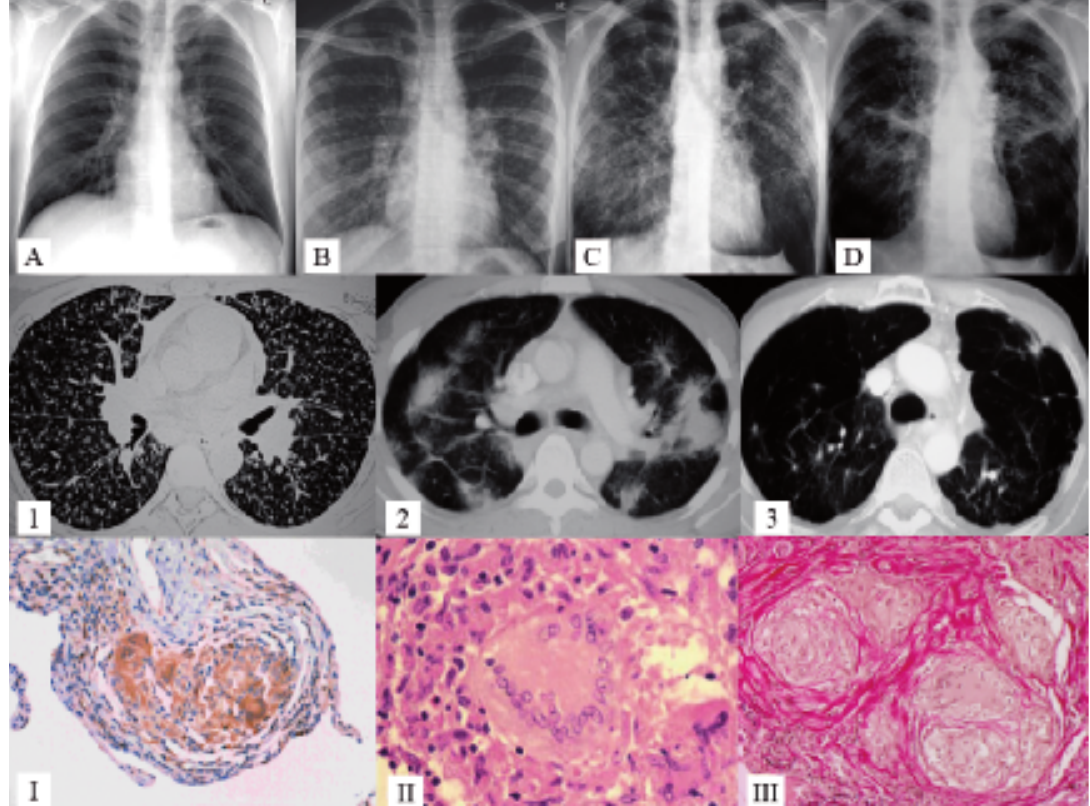
Radiological and histological appearances of sarcoidosis. Top row panels A–D show the stages I–IV of the classification of pulmonary sarcoidosis according to Siltzbach [45]. Stage I is defined as bihilar lymphadenopathy (BHL) and is associated with 55–90% complete remission. Stage II consists of BHL and pulmonary infiltrates (40–70% remission). Stage III is charac- terised by pulmonary infiltrates/interstitial lung disease in the absence of BHL (10–20% remission). Stage IV represents pul- monary fibrosis (0% remission). In the middle row panels specific computed tomography findings are given: panel 1 shows BHL, nodular and reticular interstitial lung involvement and subpleural nodules. Panel 2 demonstrates BHL with parenchy- mal consolidations of the lungs. Panel 3 represents end-stage lung fibrosis in combination with emphysematous changes. Examples of histological slides are shown in the bottom row: panel I: Histology of a typical non-caseating epitheloid-cell granuloma; panel II: Large magnification of a polynucleated giant (Langerhans) cell; panel III: Dense fibroproliferative scar tissue around epitheloid cell granulomas (Histological slides are kindly provided from Prof. L.